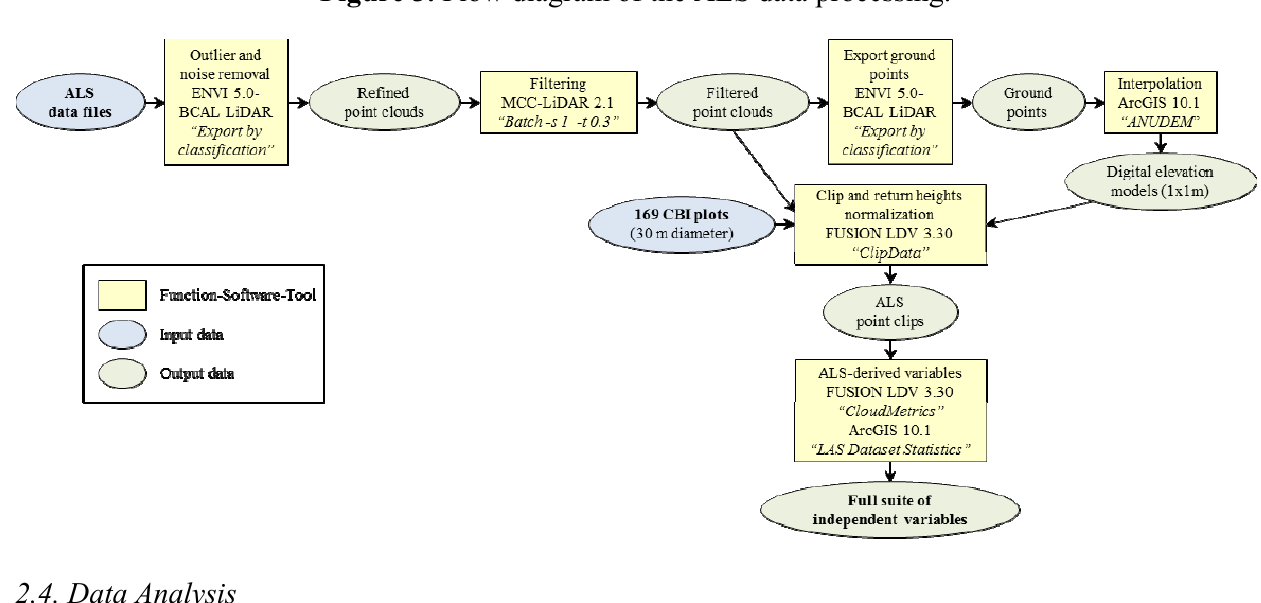
Figure 3. Flow diagram of the ALS data